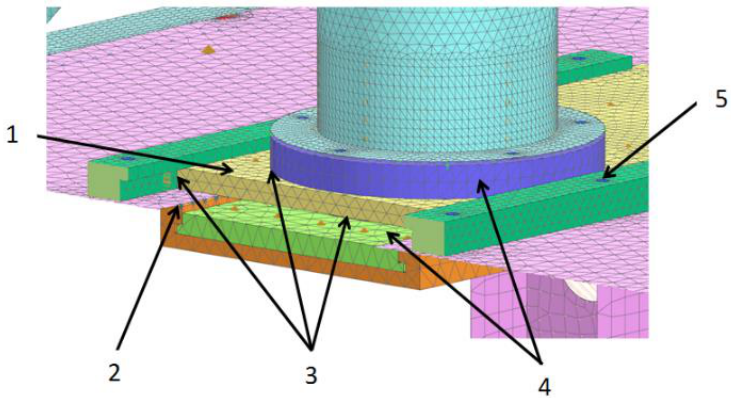
Figure 6. Calculation model of molding module connecting the die assembly with the molding cen- ter and table (runner rail: bolted connection, sliding elements, contact set, RBE2 rigid elements, and matrix assembly) and modeling of the interconnection of the die assembly with the forming center and table. 1. Die assembly, 2. RBE2 rigid elements, 3. Contact set, 4. Sliding elements, 5. Guide screw connection (1D elements)